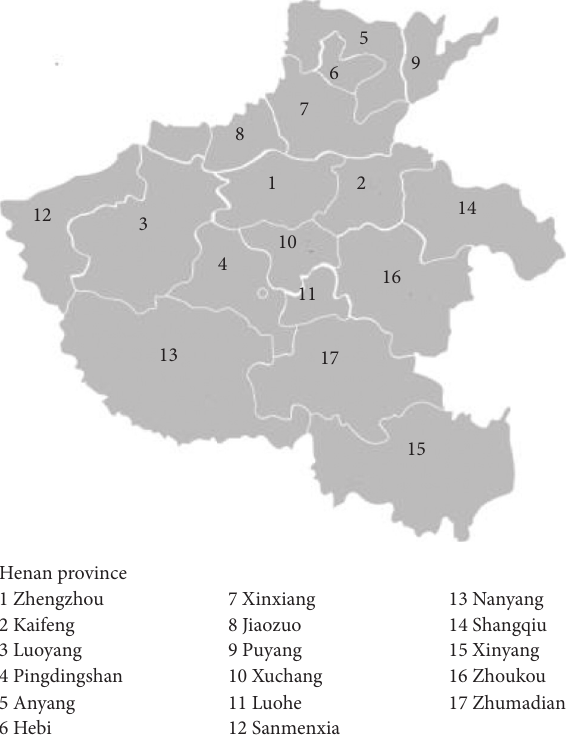
Figure 2: Urban distribution map of Henan